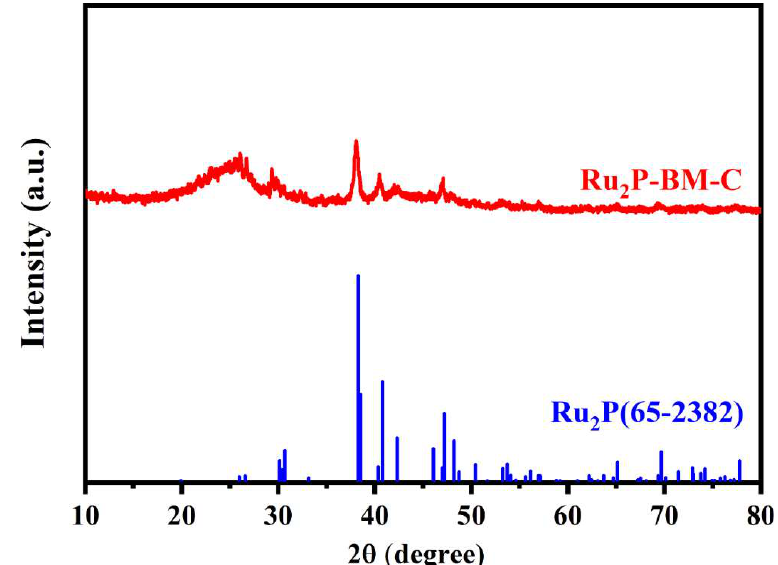
Figure 1. XRD pattern of Ru 2 P-BM-C. Catalysts 2019 , 9 , x FOR PEER REVIEW